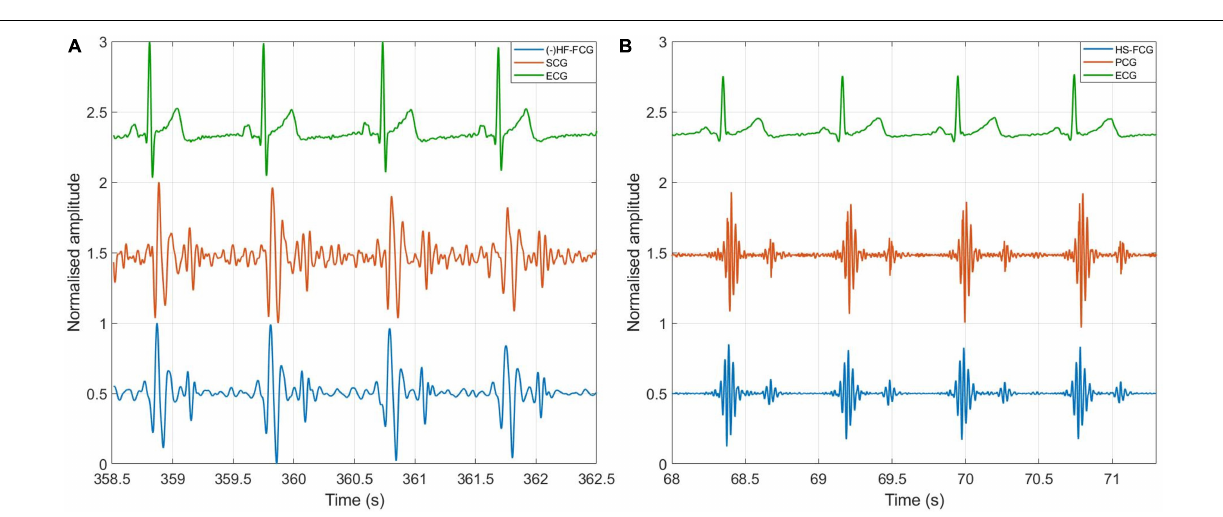
also in terms of acoustic impression ( Supplementary Audio 1